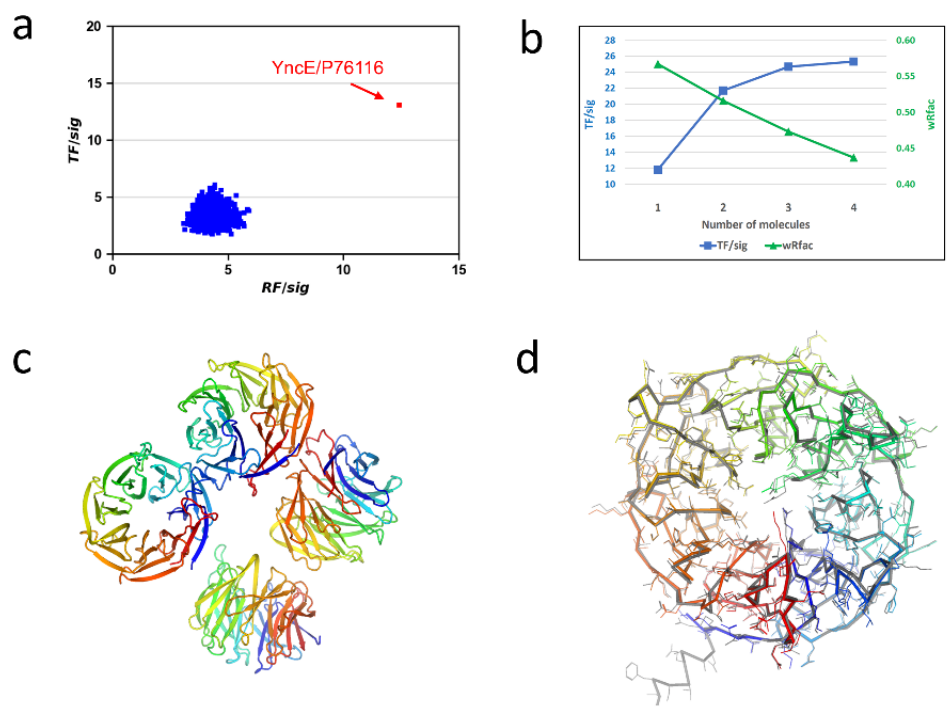
Figure 2. Alphafold structures for phasing E. coli YncE . ( a ) Histogram of rotation and translation peaks. ( b ) Progressive molecular replacement while searching for four molecules in a.u. ( c ) Refined YncE structure. ( d ) Comparison of the refined structure with the AlphaFold structure. The AlphaFold-predicted structure is shown in gray.